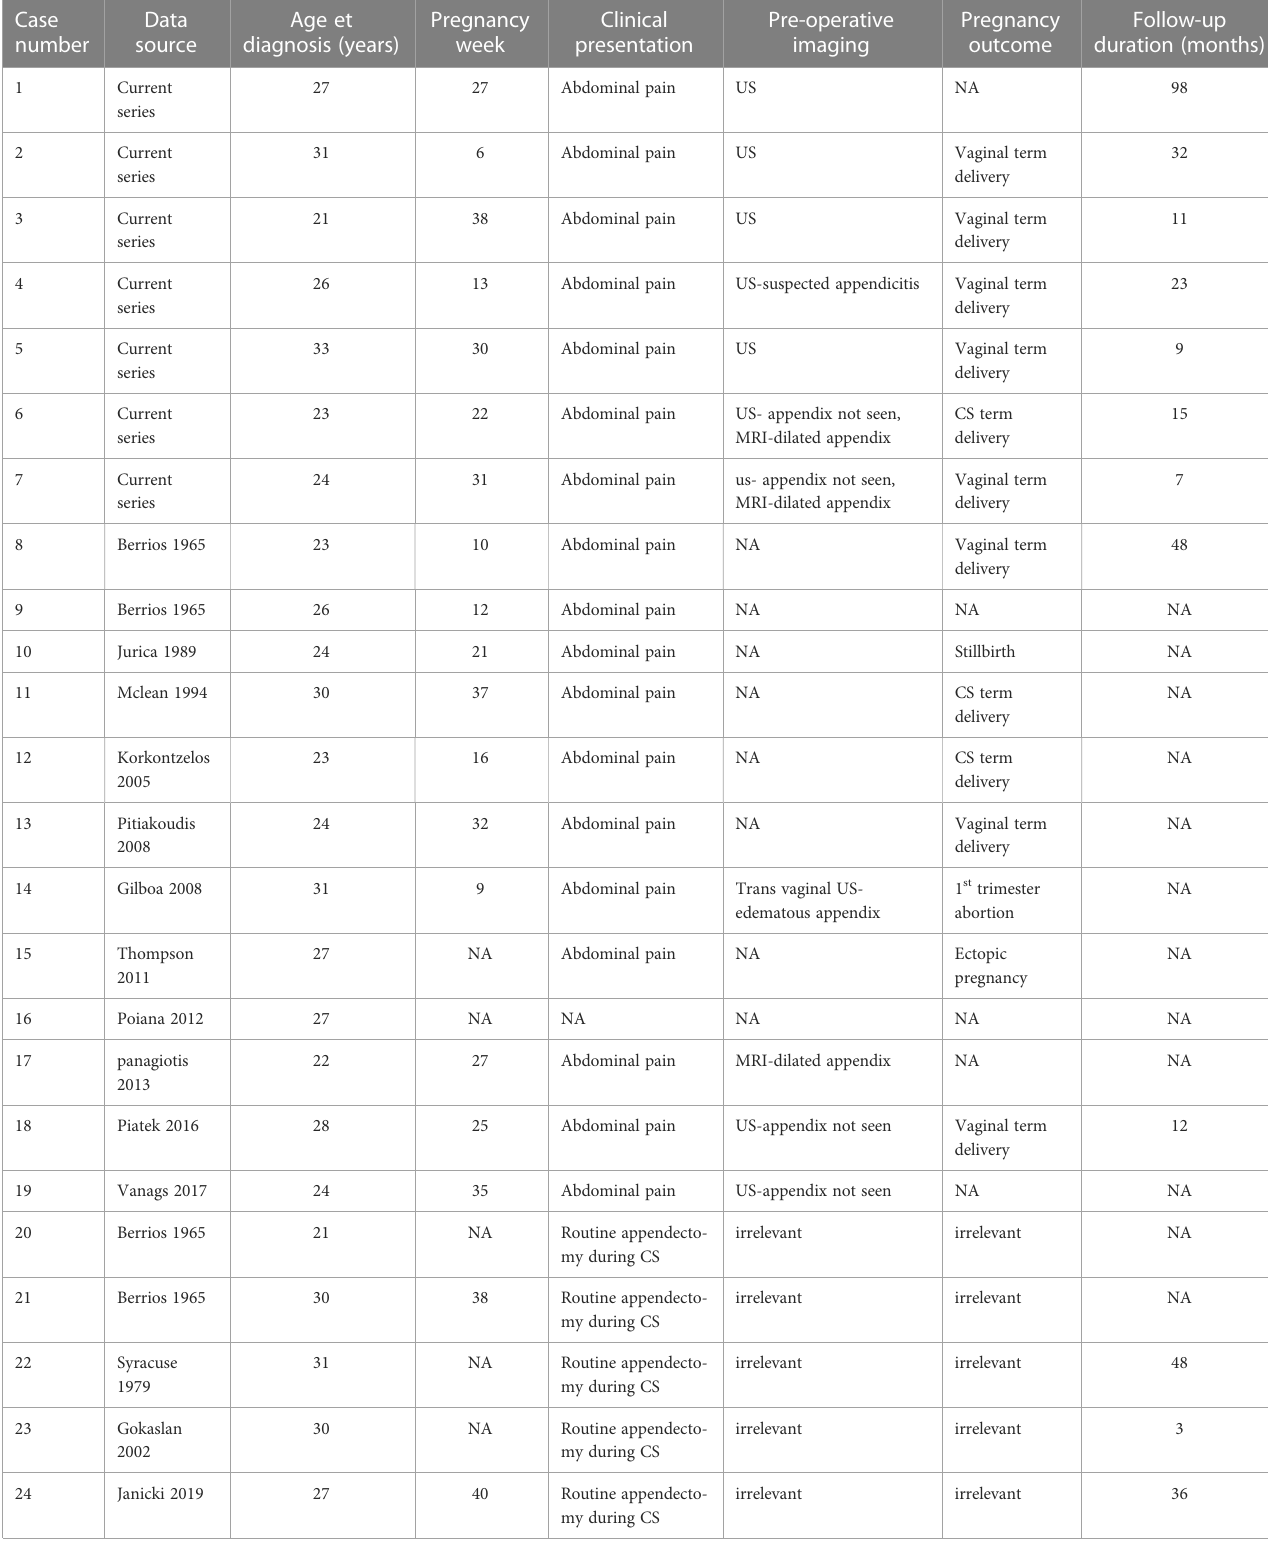
TABLE 1 Clinical characteristics of 24 appendiceal neuroendocrine neoplasms diagnosed during